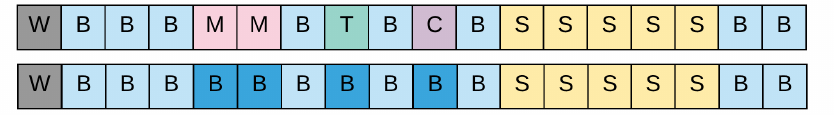
Figure 4. Results of initial classification (first row) and the Healing algorithm (second row) for the second special case.